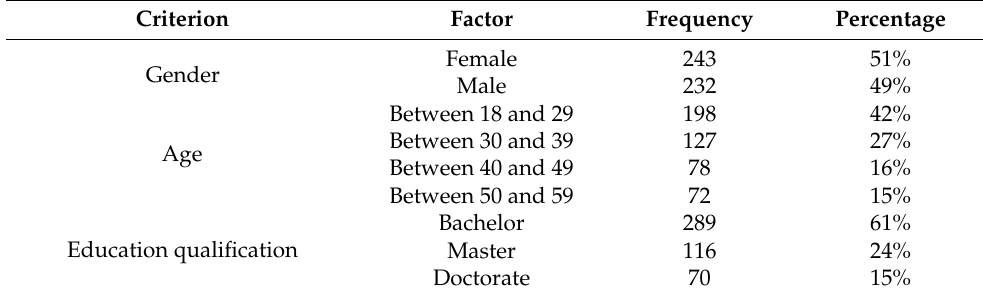
Table 2. Demographic data of the respondents.